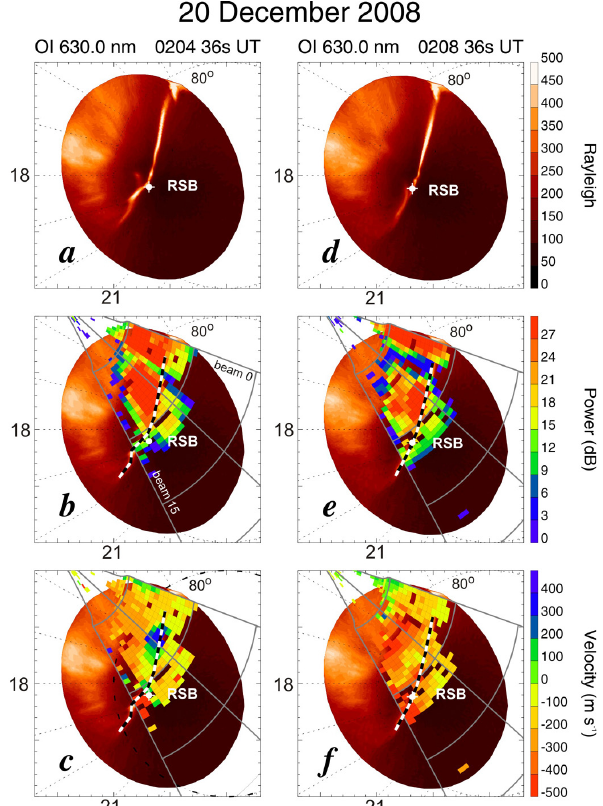
Fig. 8. Resolute Bay all-sky camera images of the polar cap arcs on 20 December 2008 at (a) 02:04 and (d) 02:08UT. Mapping is done in MLAT-MLT coordinates. (b) and (e) Inuvik radar power maps and locations of the polar cap arc (dashed lines). (c) and (f) Inu- vik velocity maps and locations of the polar cap arc (dashed lines). Range ticks within the radar field-of-view correspond to gates 15, 30, 45 and